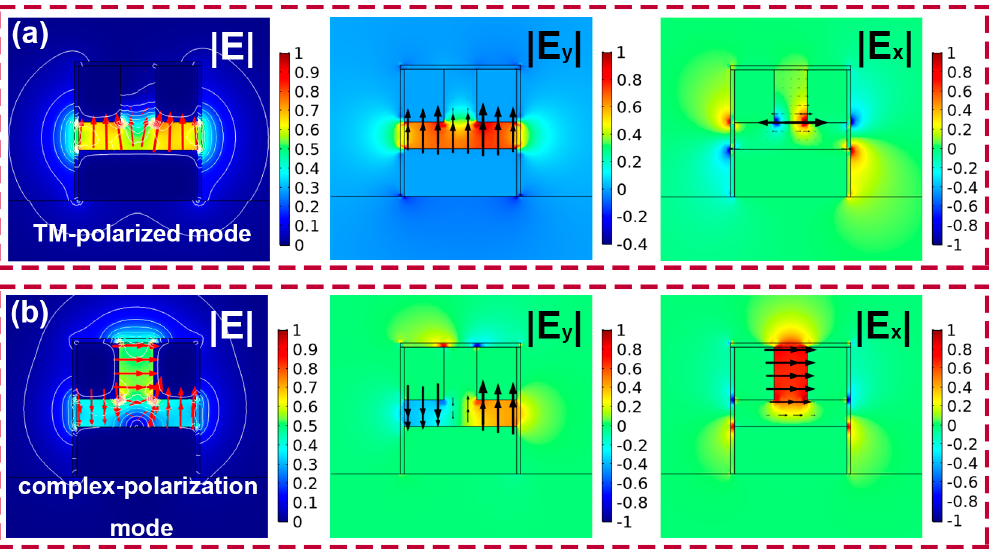
Figure 3. The electric field distributions of ( a ) transverse magnetic (TM) polarized mode and ( b ) complex-polarization mode. The color bars and arrows represent the intensity and direction of the electric field, respectively.